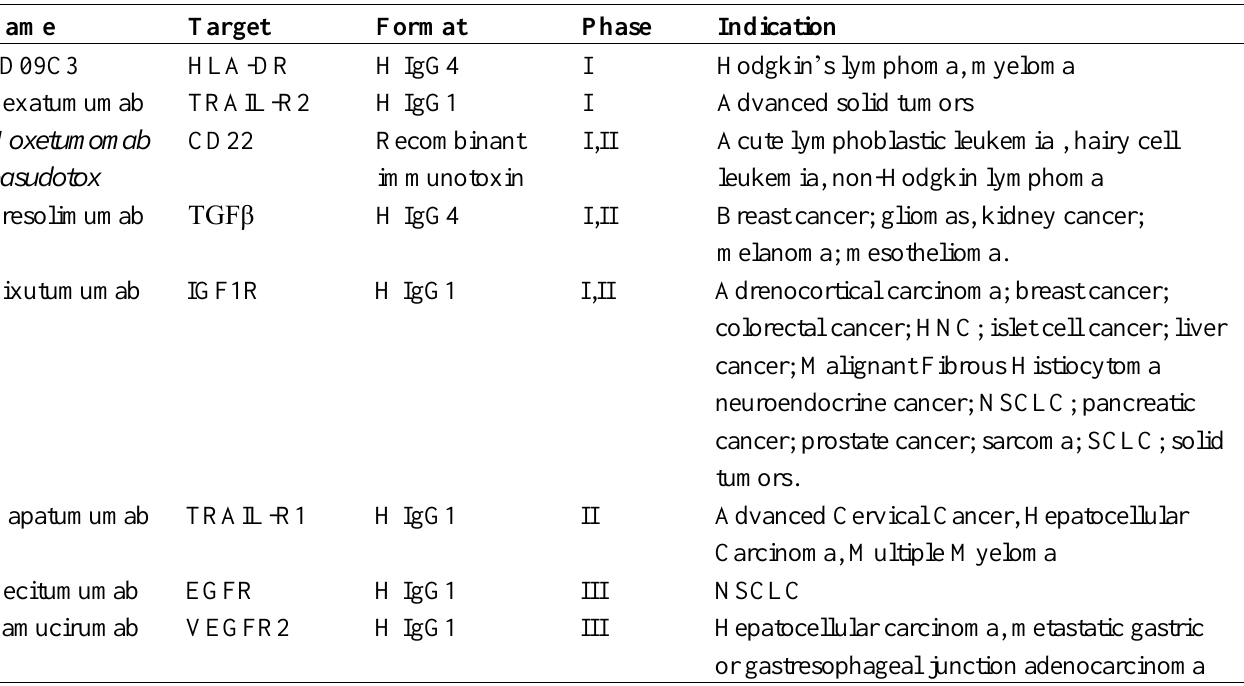
Table 1. Examples of monoclonal antibodies derived from phage display technology currently under evaluation for cancer therapy in clinical trials. Phage display monoclonal antibodies used in clinical